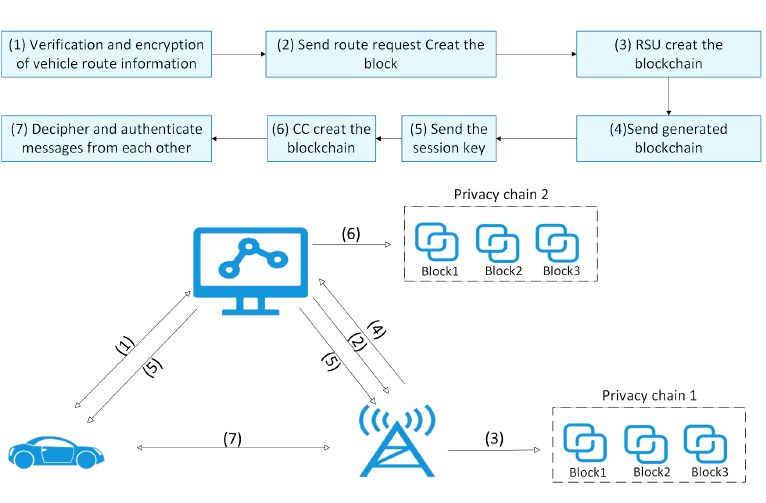
Figure 11. A security scheme based on blockchain and hybrid cryptosystem proposed in